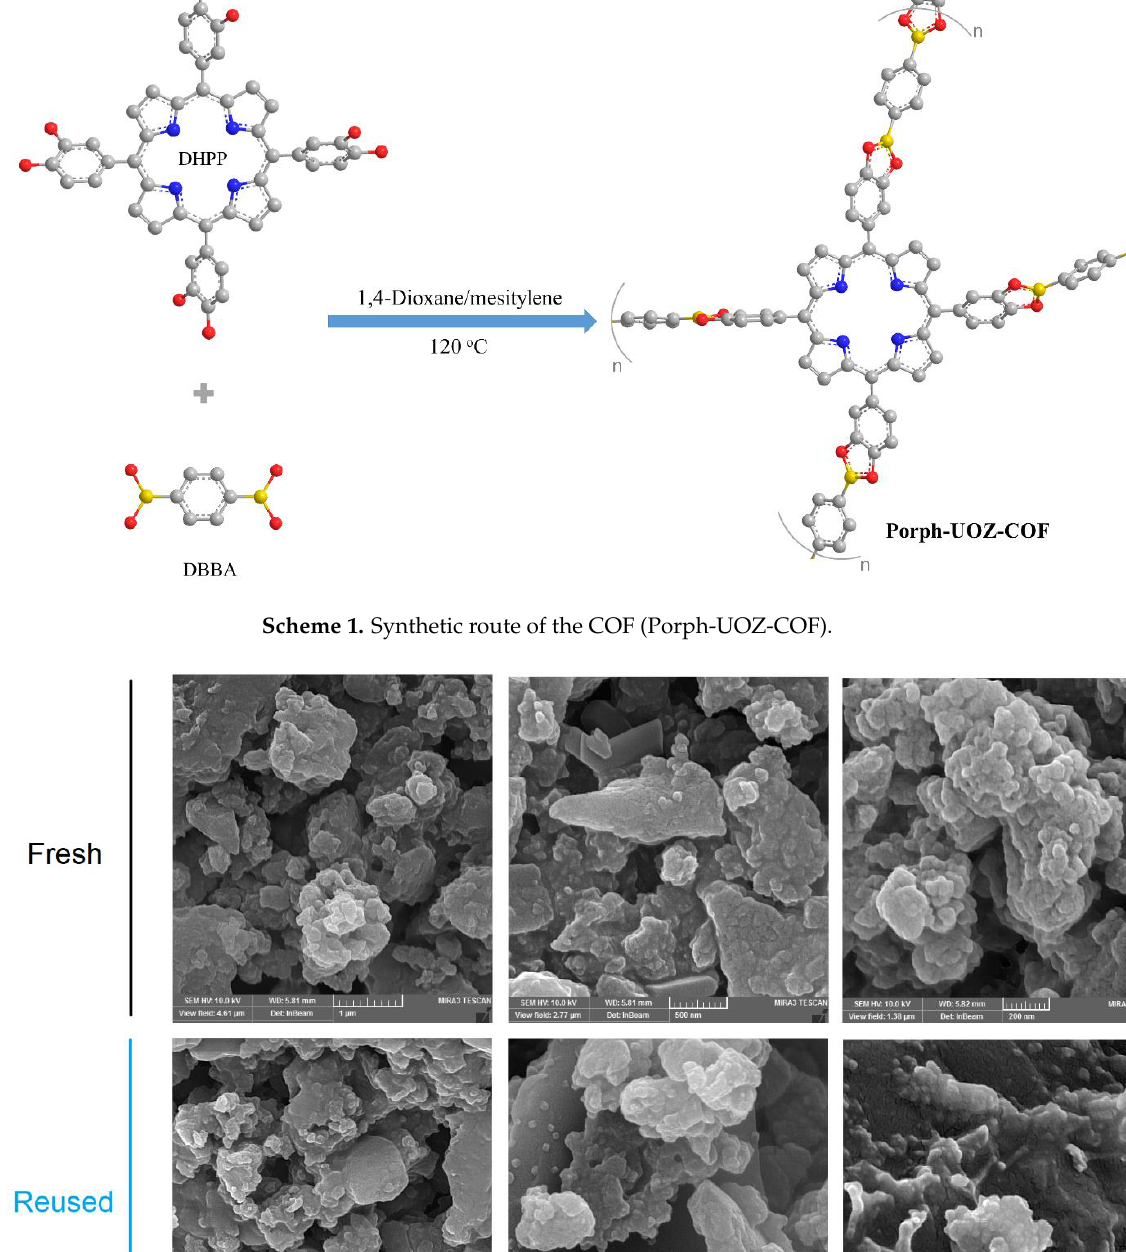
Figure 1. FESEM images of the resulting fresh and reused polymer.